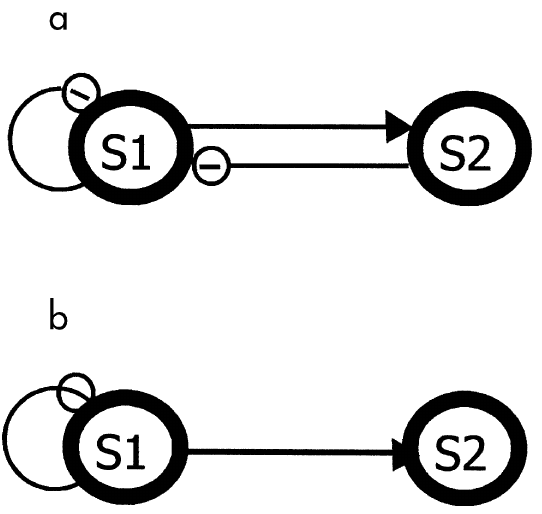
Fig. 1. Symbols and interrelations between two species (S1 and S2), utilised in loop